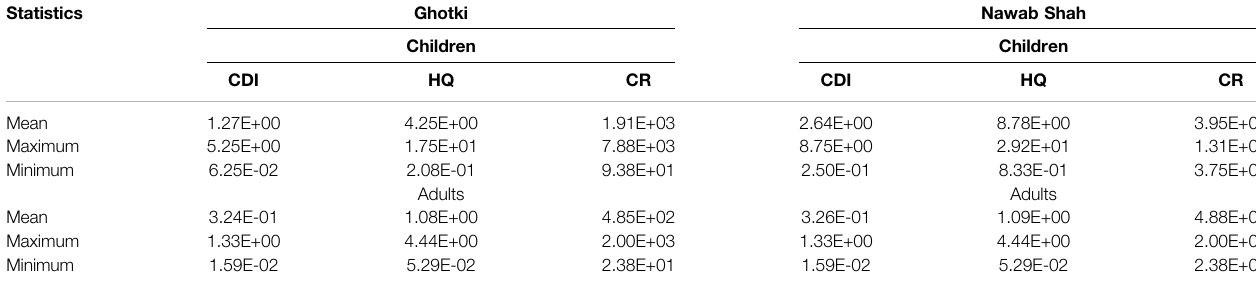
TABLE 4 | Health risk assessment of arsenic (As) in groundwater sources of the Ghotki and Nawab Shah